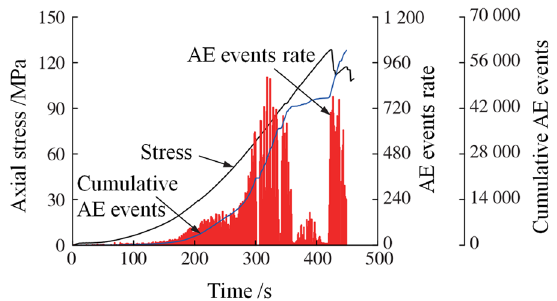
Fig. 12 Research result of Zhao et al.